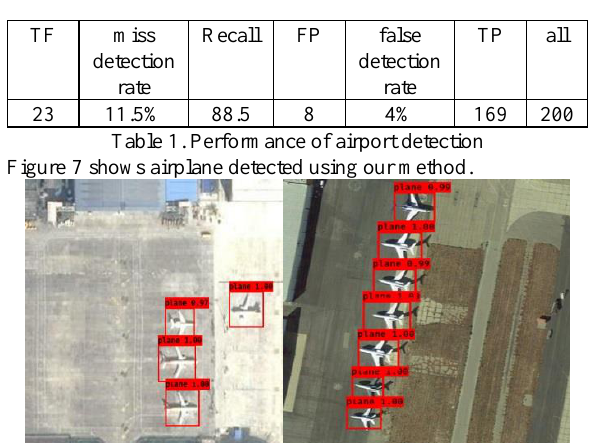
Figure 6. Results of airport detection